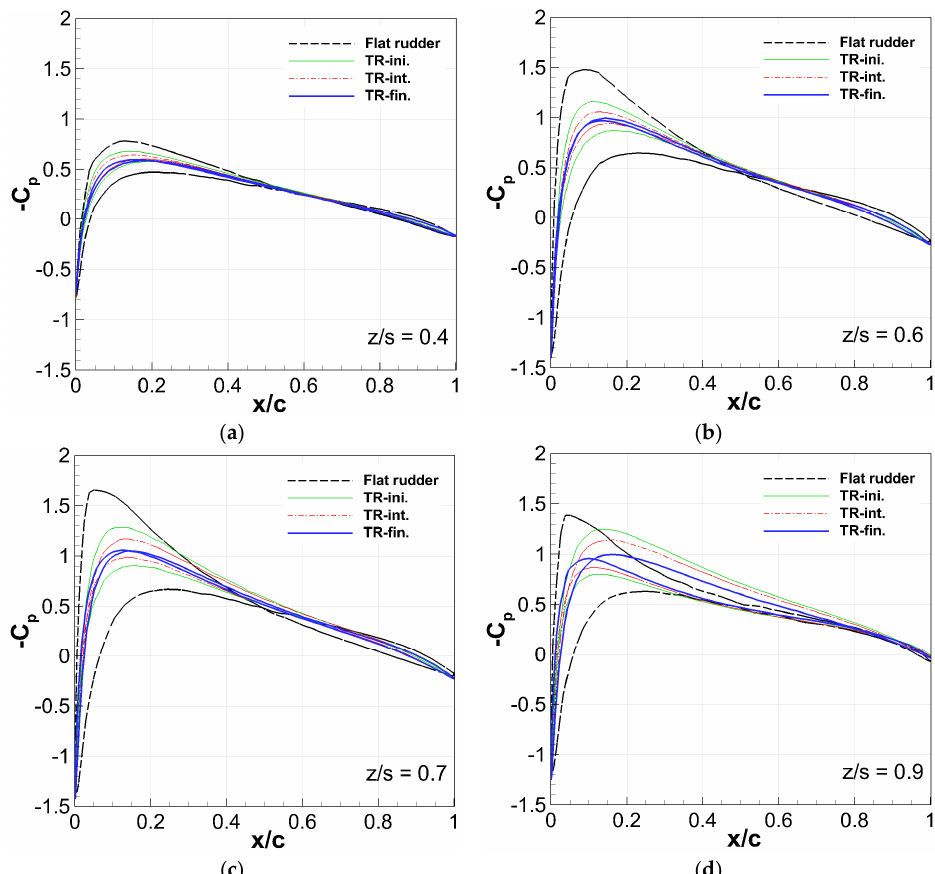
Figure 15. Pressure distributions along the chord lines on the twisted rudders: ( a ) z/s = 0.4; ( b ) z/s = 0.6; ( c ) z/s = 0.7; ( d ) z/s = 0.9.